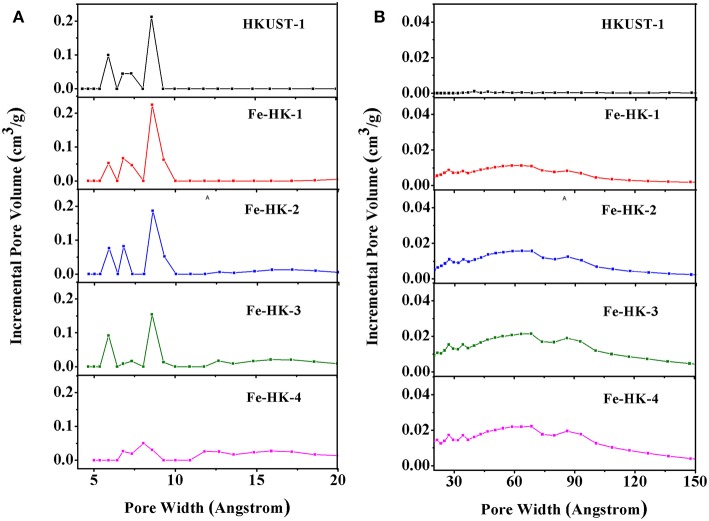
Pore size distribution curves of HKUST-1 and Fe-HK samples (A) micropore and (B) mesopore.